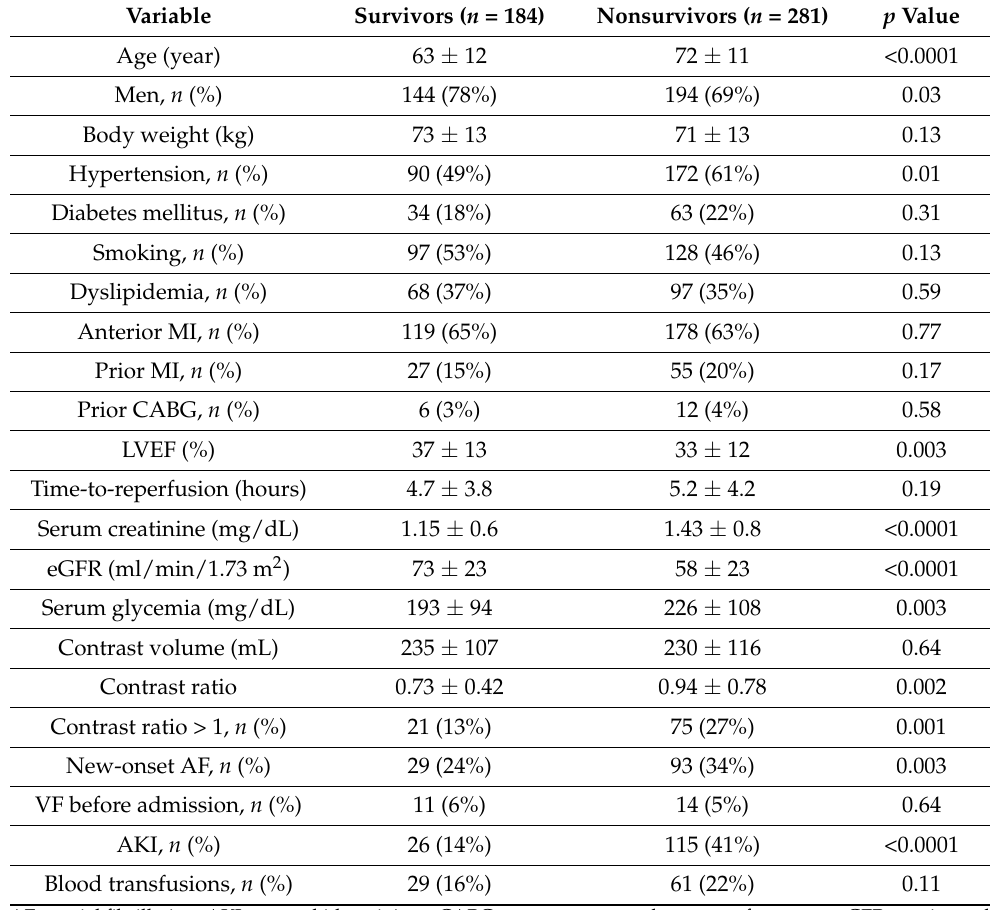
Table 1. Baseline characteristics and in-hospital complications of survivors and non-survivors at overall follow-up, including the in-hospital and the post-discharge observation